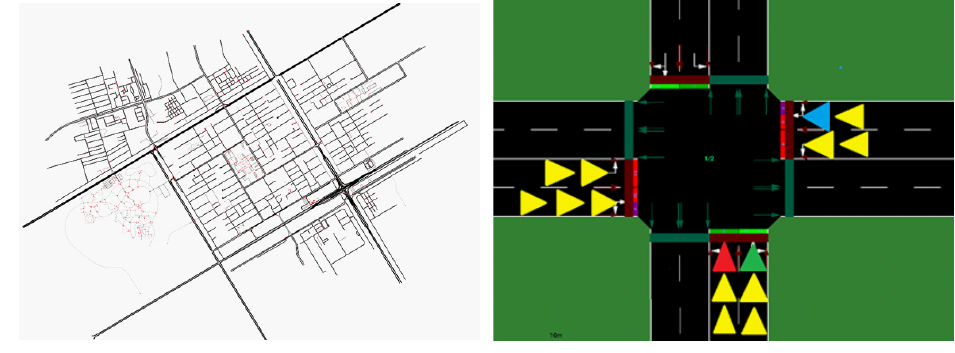
Figure 3. OSM map with intersection network used for vehicles in platoons; with leader vehicles in red, green and